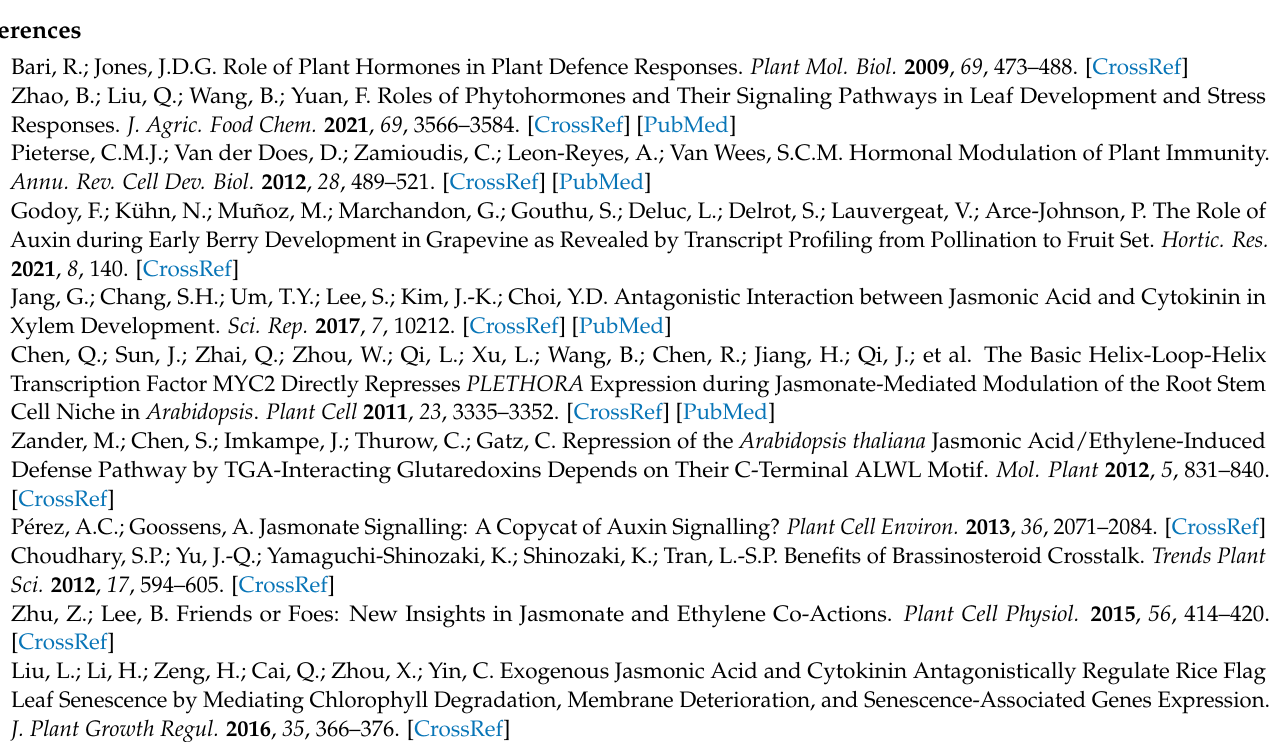
Table S5: Linearity, LODs and LOQs of IAA and IBA in dMRM